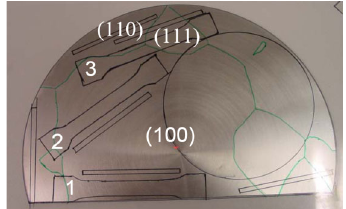
FIG. 6. Samples positioned in the LG disk for tensile and bulge